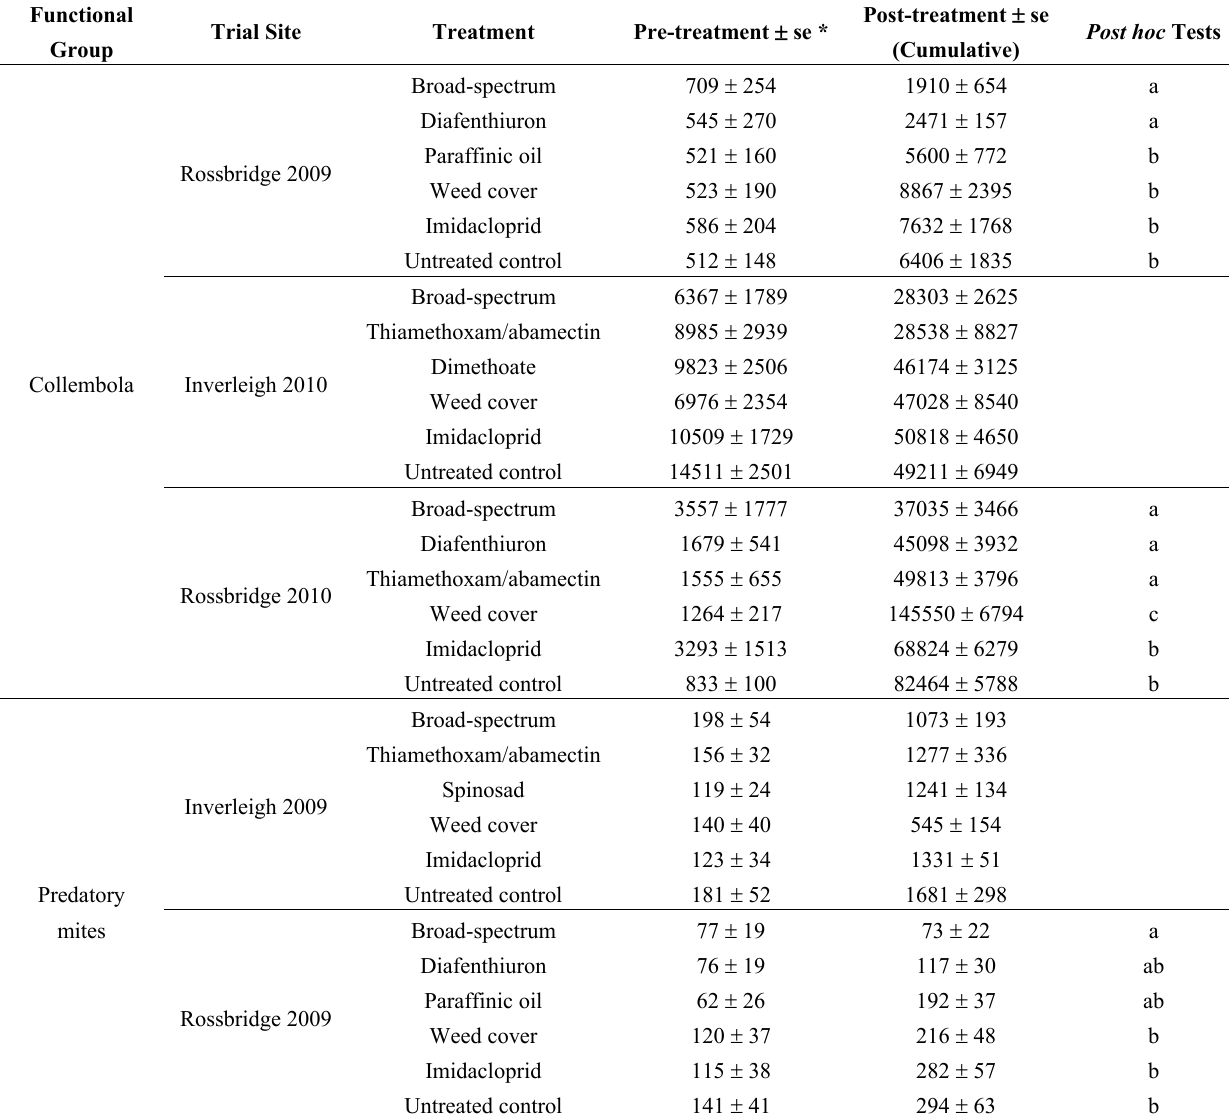
Table 3. Pre-treatment and cumulative numbers of non-target invertebrates (and standard errors) collected from all sampling dates post-chemical treatment for each case where repeated measures ANOVAs indicated a significant effect. Results from one-way ANOVAs comparing all treatments across each field site are displayed, where PreBE or post sowing sampling dates were used as covariates in the analyses. Different letters indicate significantly different means (at the p < 0.05 level, Tukey’s- b post hoc